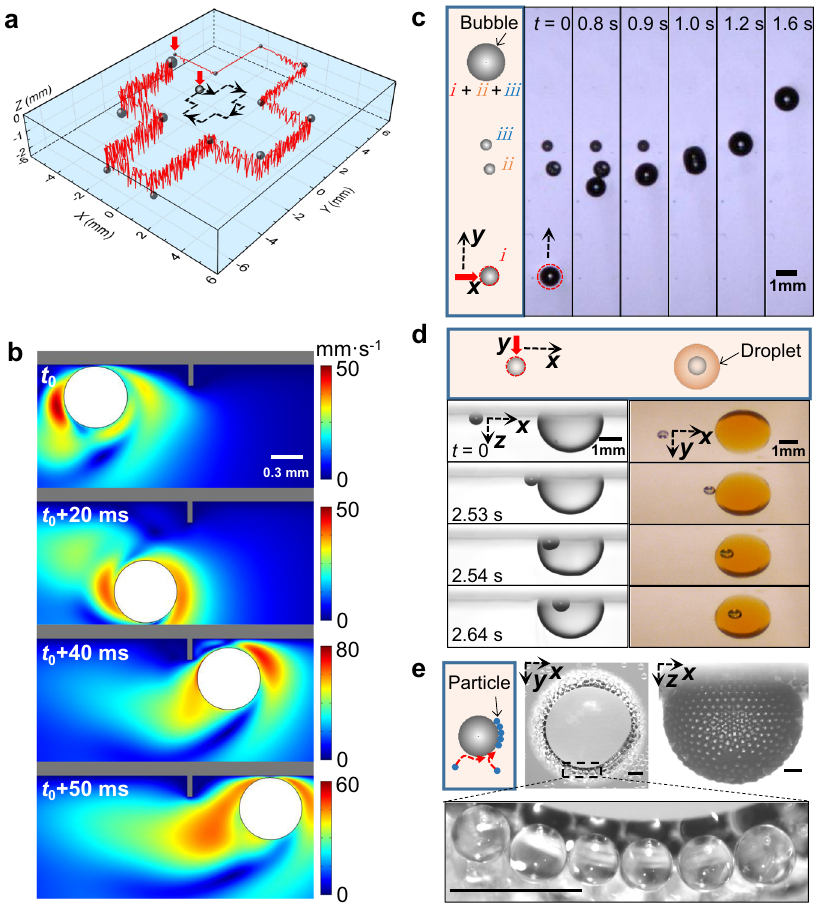
Fig. 5 | Utilizing the features of the dancing bubble. a 3D manipulation of the dancingbubble,asshownbyitstrajectorywiththetranslationspeedof2mm/s,the redarrowfortheinitialposition. b Simulationforthedancingbubbletoleapovera wall. c The coalescence of bubbles ( ii and iii ) with the dancing bubble ( i ) along its pathway under a moving speed of 5 mm/s. d The encapsulation of the dancing